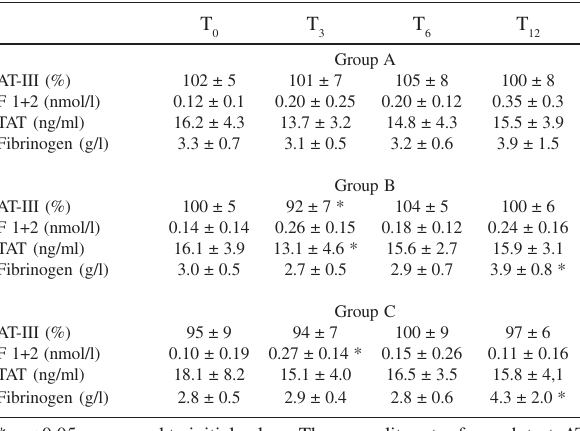
Table 1 - Results (mean ± standard deviation) of AT, F1+2, TAT, and fibrinogen determinations during one year of hormone replacement therapy (T receiveing oral CEE (group A), oral CEE plus MP (group B), or transdermal 17 β -estradiol plus MP (group C).